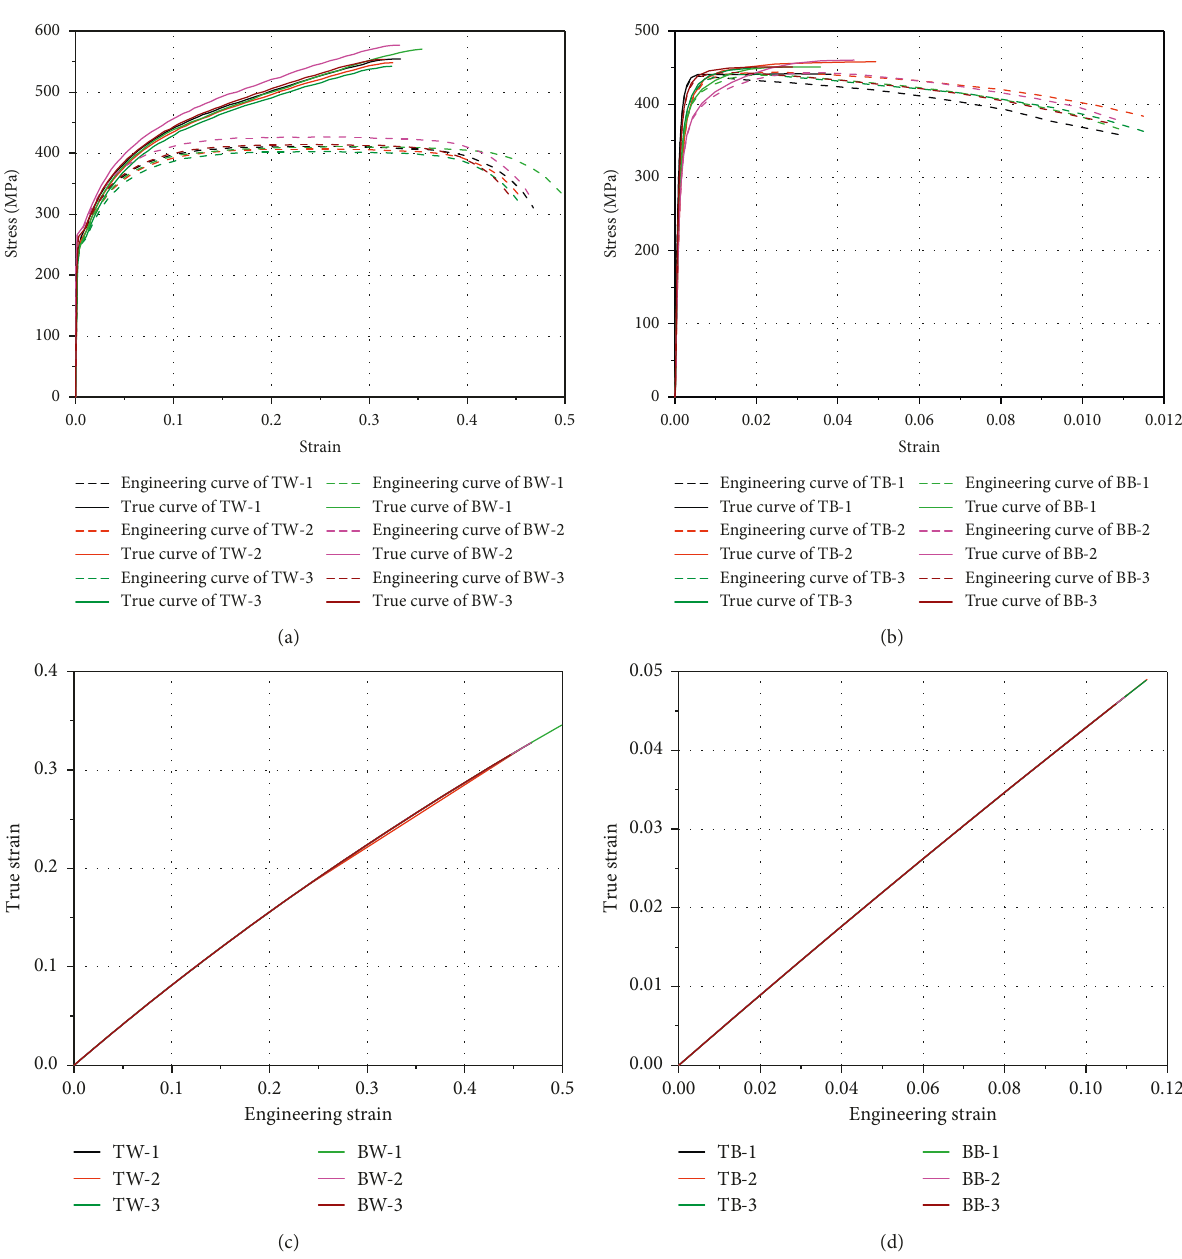
Figure 12: Comparison of true and engineering stress-strain curves of flat and corner coupons: (a) true and engineering stress-strain curves of flat coupons; (b) true and engineering stress-strain curves of corner coupons; (c) relationship between true and engineering strains of flat coupons; (d) relationship between true and engineering strains of corner